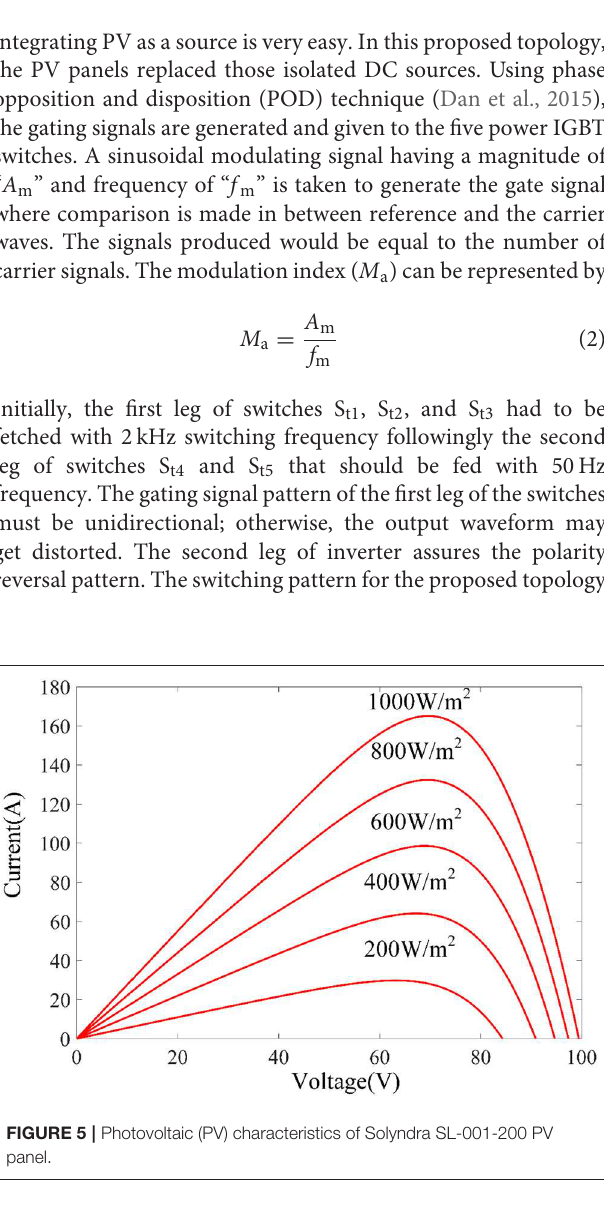
TABLE 2 | Solyndra SL-001-200 (200W) solar photovoltaic (PV) panel